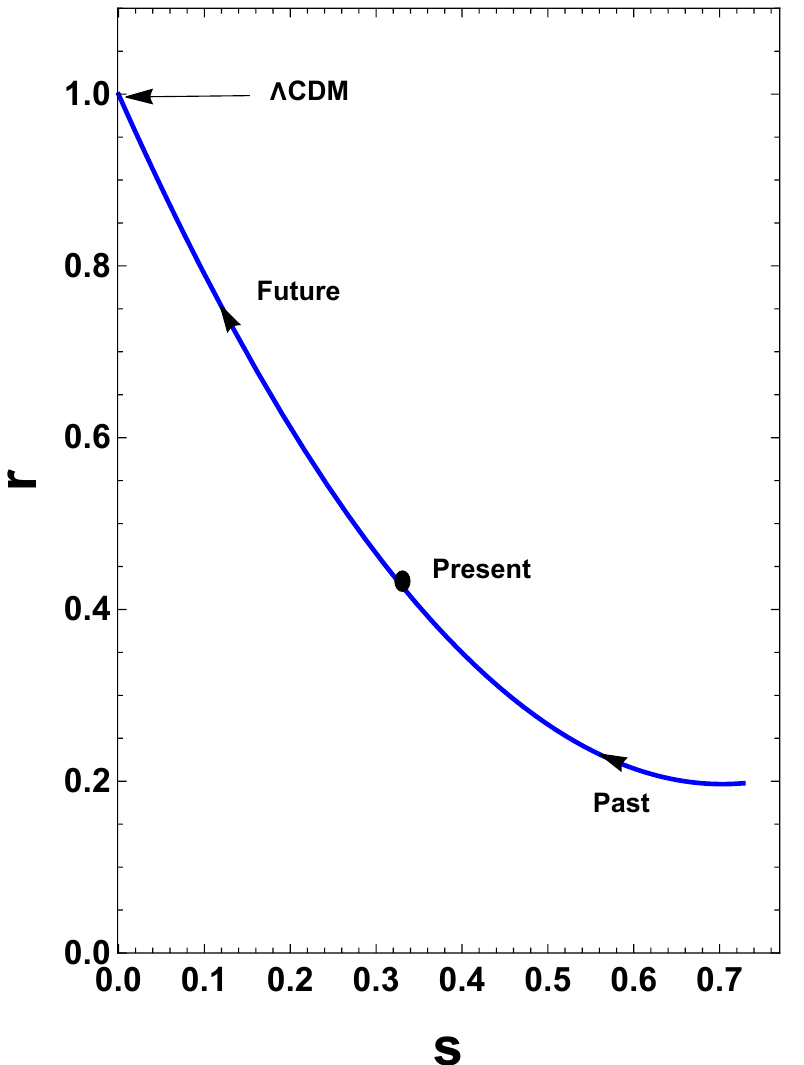
Figure 5. Profile of the evolution trajectory of the given model in the r – s plane, with the agreement of obtained observational